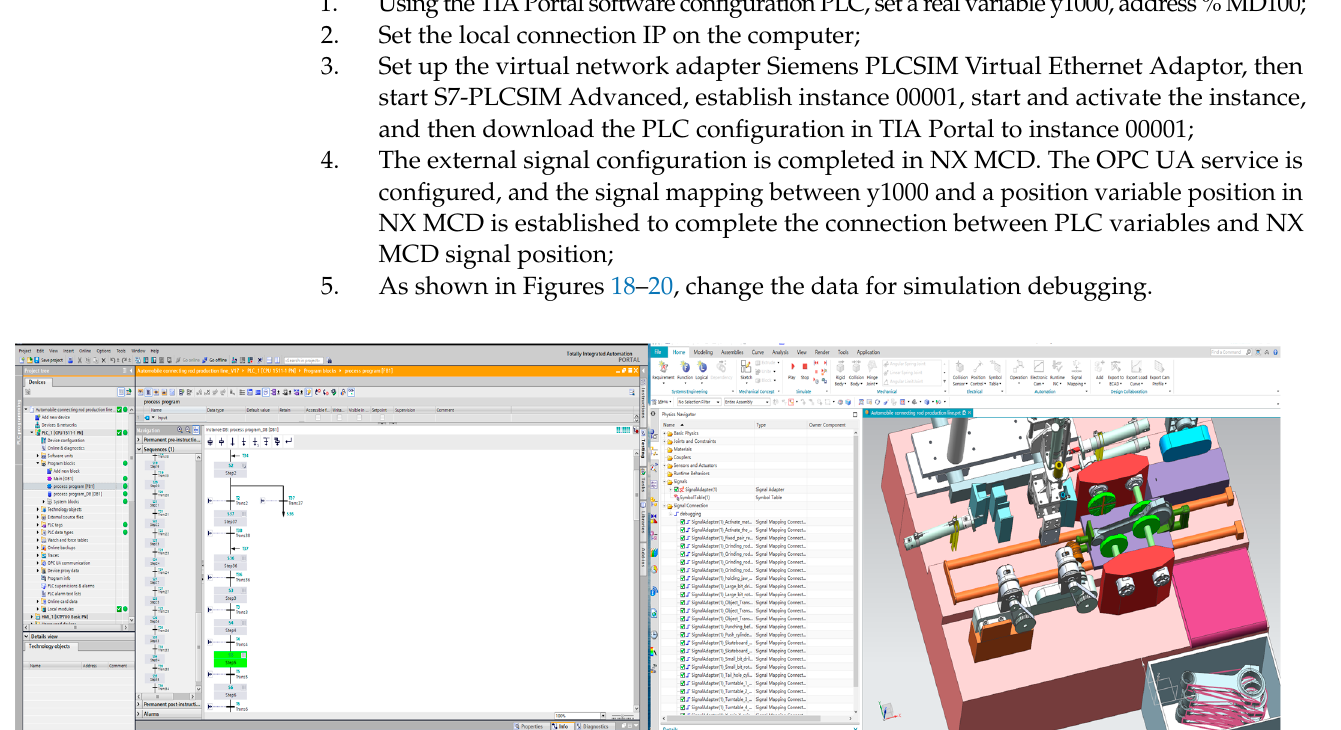
Figure 20. Real-time debugging of bolt-hole processing. 2.5.4. Problems Encountered in Debugging the First Part of the Processing Area An example is given by the connecting rod falling during the debugging process. As shown in Figure 21, the connecting rod suddenly falls during the operation of the crane. Figure 21. Connecting rod drop in debugging of the first part of the processing area.